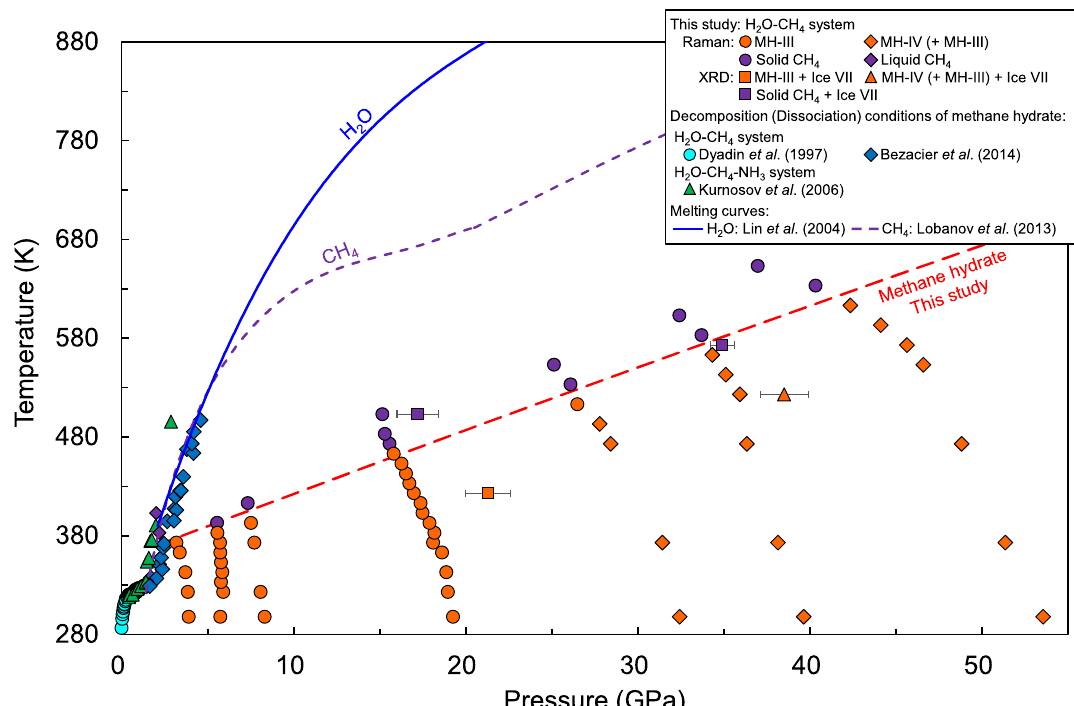
Fig. 5 Stability region of MH-III and MH-IV based on sequential Raman spectra. MH-III melts below 2.5 GPa and decomposes into solid methane and ice VII above 2.5 GPa. MH-IV exhibits solid decomposition. The broken line indicates the obtained dissociation curve. The dissociation curve is approximately 200 K lower than the melting curves of solid methane and ice VII. This figure is modified from Kadobayashi et al.